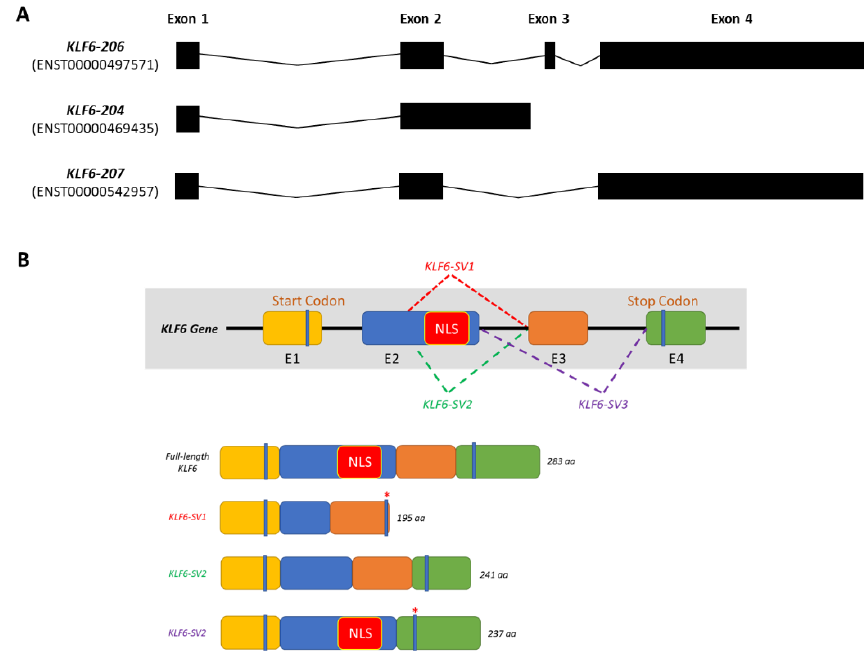
Figure 1. KLF6 gene structure and the associated post-transcriptional modifications. ( A ) The KLF6 gene can be transcribed to produce 7 different transcripts, of which only KLF6-204, KLF6-206 and KLF6-207 are translated into proteins. ( B ) The primary KLF6 transcript, KLF6-206, contains four exons whereby germline mutation IVS 1-27 G > A can induce alternative splicing that gives rise to three additional KLF6 spliced variants: KLF6-SV1, KLF6-SV2 and KLF6-SV3.